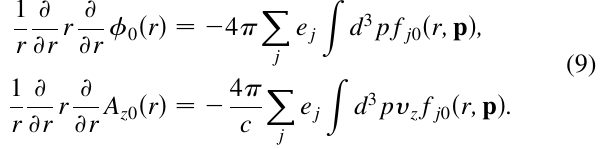
and ^ nn are the electron e b